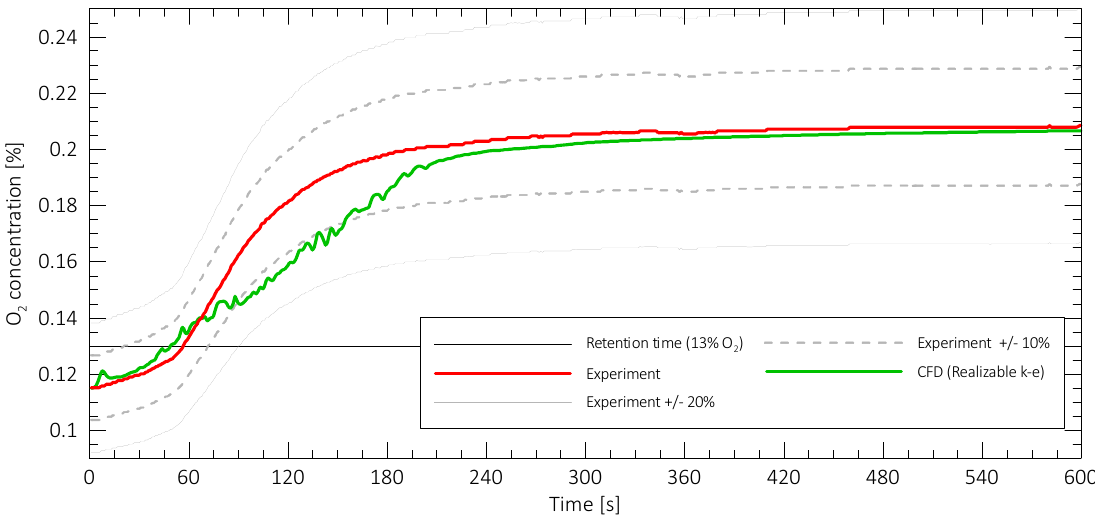
Figure 13. Changes in oxygen concentration (v/v) on the probe No. 1, indicating the end of the retention time during experimental tests and CFD simulations, fire-extinguishing gas Ar 50% v/v and N 2 50% v/v.